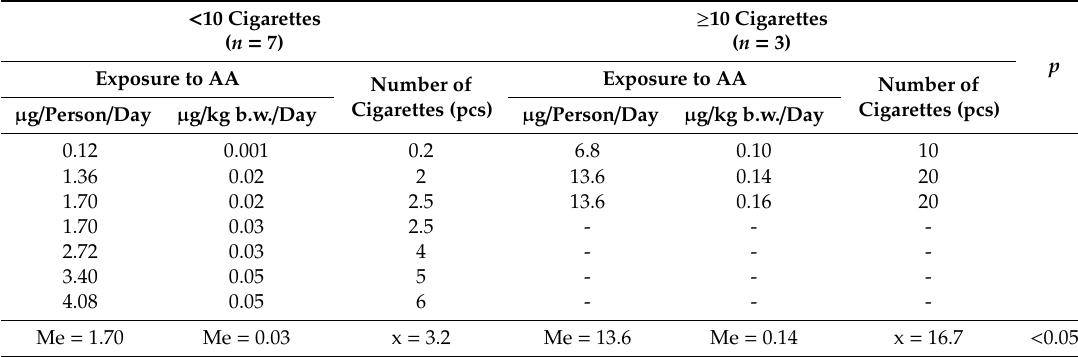
Table 2. Estimated exposure of pregnant women to acrylamide from tobacco smoke, depending on the